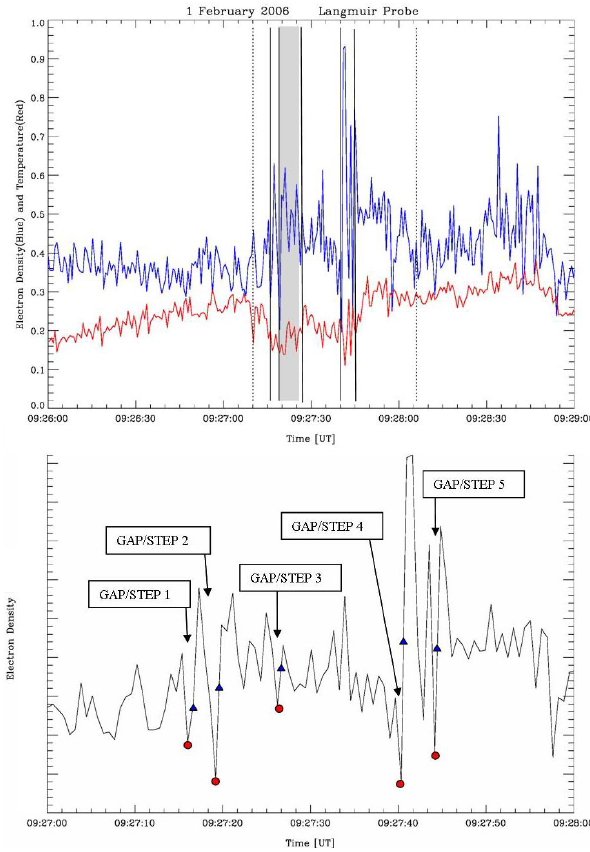
Fig. 4. The upper panel shows the Langmuir Probe electron-density (blue) and temperature (red) versus time. The first dotted verti- cal line (09:27:10UT) indicates when the ion is observed and the last dotted line (09:28:06UT) corresponds to end of the observed ions. The first solid lines correspond to the border of the first ion step and electron gap, and so on: ∼ 09:27:16UT, ∼ 09:27:19UT, ∼ 09:27:28UT, ∼ 09:27:41UT and ∼ 09:27:46UT. The shaded area corresponds to the time interval between ∼ 09:27:19:20UT and ∼ 09:27:26:30UT, the main period of electron fluctuations. The lower panel illustrates how the rising flanks (blue triangle) after considerable gaps in the electron density are in accordance with the start of each step in the ion-dispersion. The red circles corre- spond to the border between each gap/step as above: ∼ 09:27:16UT, ∼ 09:27:19UT, ∼ 09:27:28UT, ∼ 09:27:41UT and ∼ 09:27:46UT. and flux vary with frequencies between 0.5–0.8 Hz.